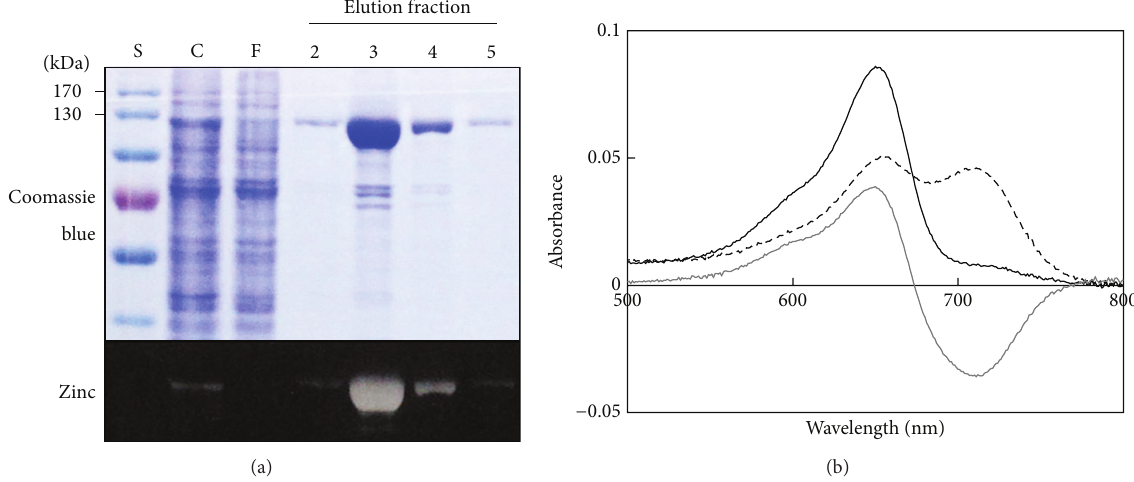
Figure 1: Photochemical analysis of purified Arabidopsis phyB proteins assembled with phycocyanobilin (PCB). (a) Purification of PCB- assembled phyB proteins by streptavidin affinity chromatography. SDS-PAGE gel was shown with Coomassie blue staining. Lane S: Fermentas prestained protein ladder; lane C:crude extract; lane F: flow-through fromthe affinity column; lanes 2–5: elution fractions of holo-phyB. Zinc- induced fluorescence assay (Zinc) was shown to confirm chromophore-assembled phyB proteins. (b) Absorption and difference spectra of the purified PCB-assembled phyB proteins. Absorption spectra of Pr (solid line) and Pfr (dotted line) were shown, and the difference spectrum (gray line) was obtained by subtracting the Pfr absorption spectrum from the Pr absorption